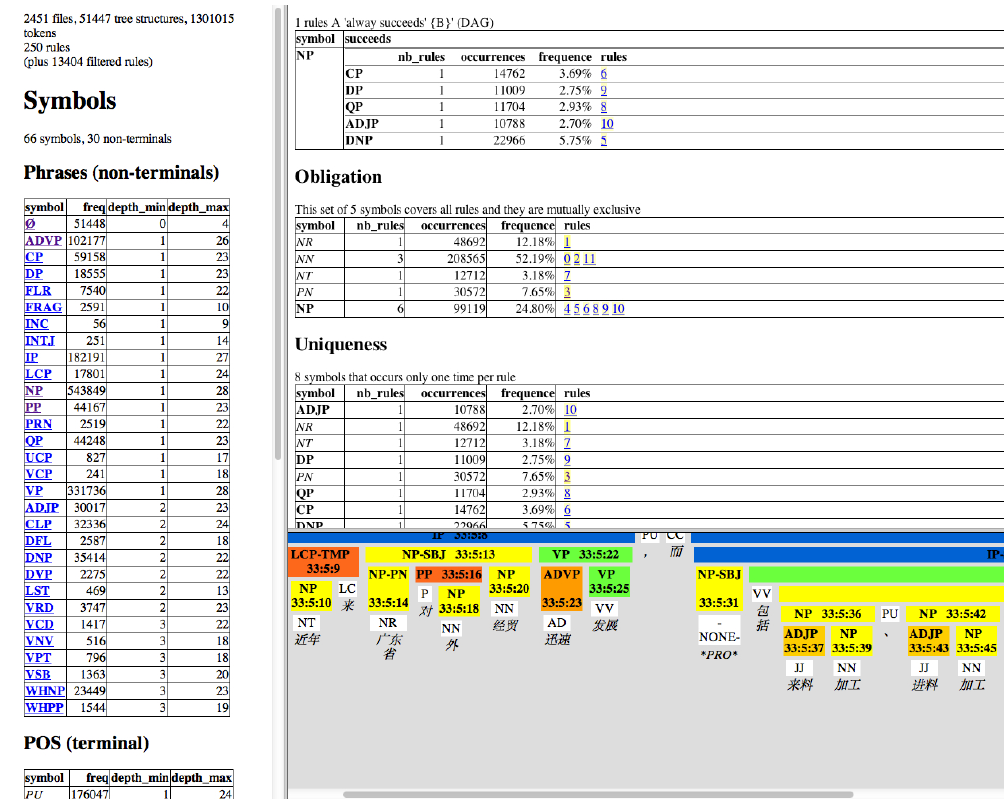
Figure 6: Properties from the Chinese Treebank